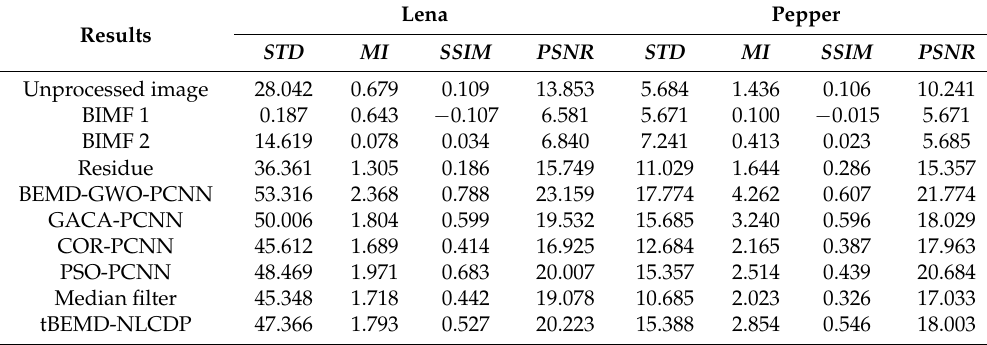
Table 3. Results from an experimental evaluation comparing indicator values of standard deviation (STD), mutual information (MI), structural similarity index measurement (SSIM) and peak signal to noise ratio (PSNR) of the unprocessed images with those from different noise reduction methods.